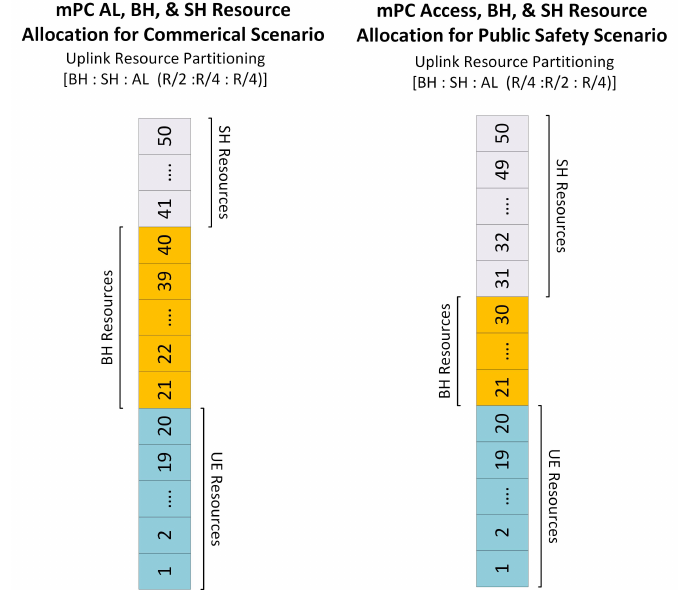
Figure 3. Dynamic resource allocation for access, backhaul, and sidehaul links.